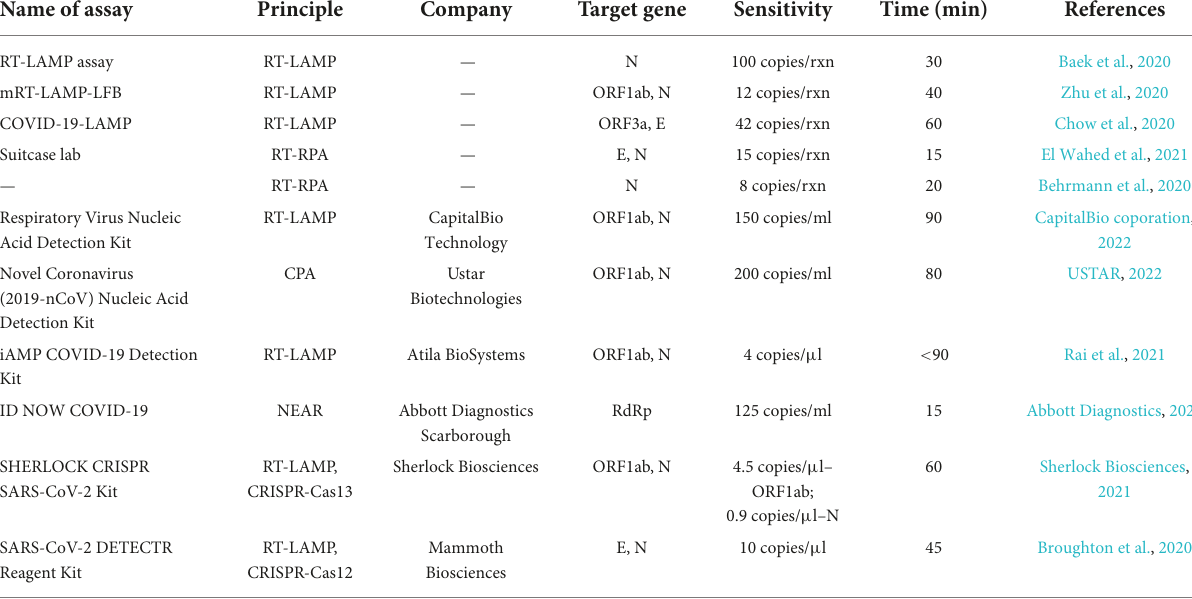
TABLE 1 Comparison of several isothermal amplification-based methods developed for SARS-CoV-2